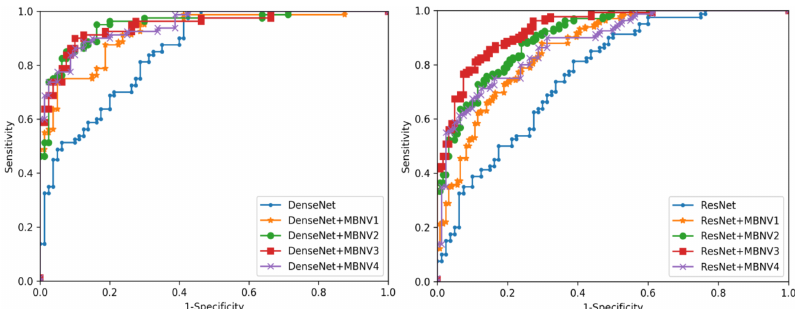
Figure 5. ROC curves of the mask branch network with DenseNet ( Left ) and ResNet ( Right ).